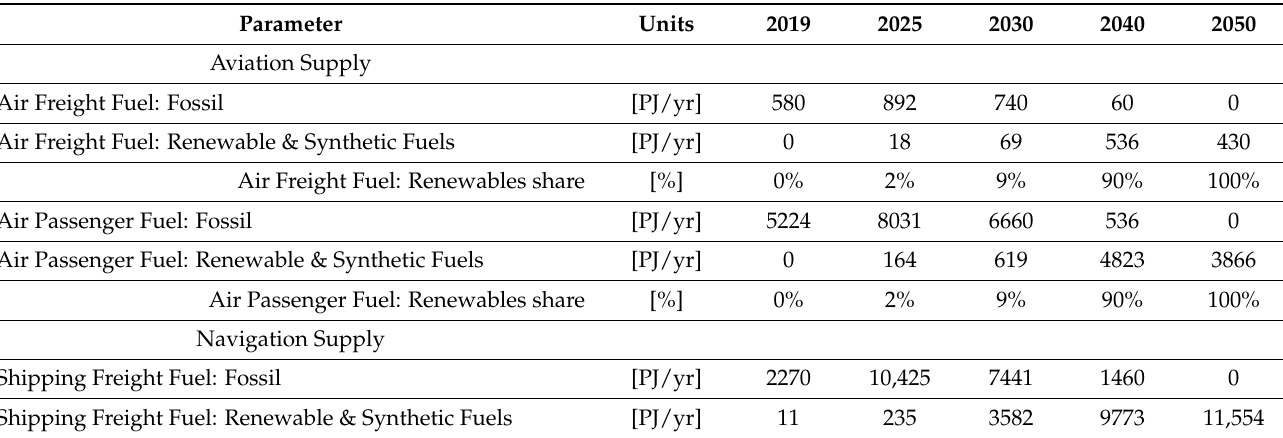
Table 19. Energy supply requirements for aviation, navigation, road transport and the manufacture of transport